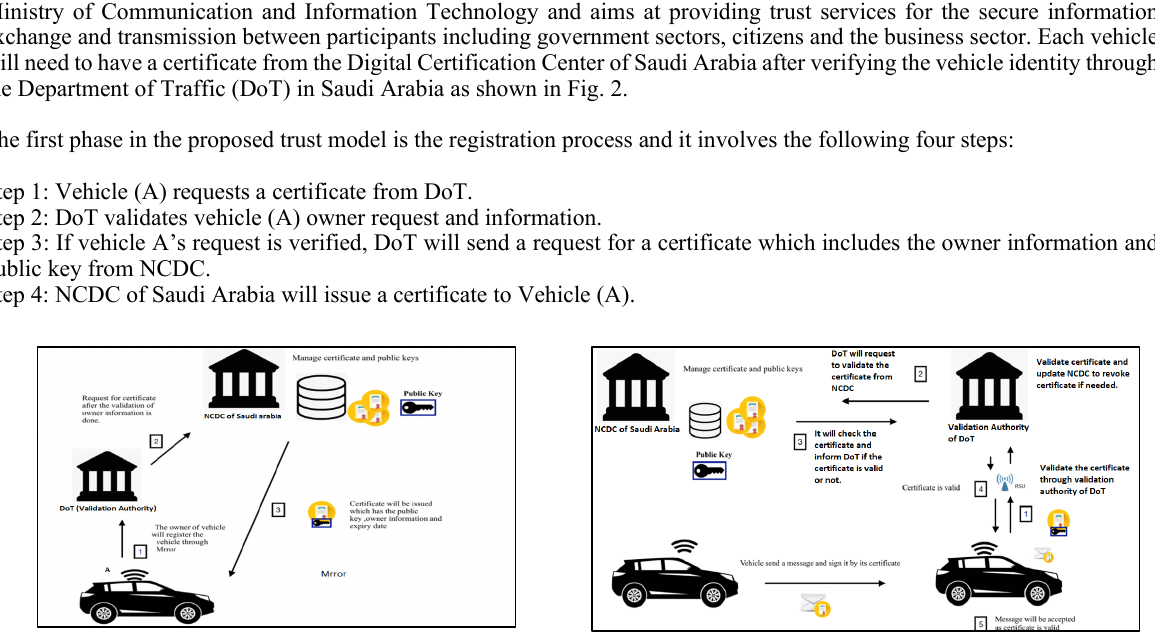
Fig. 2. Proposed Trust Model Registration Phase Fig. 3. Certificate Validation